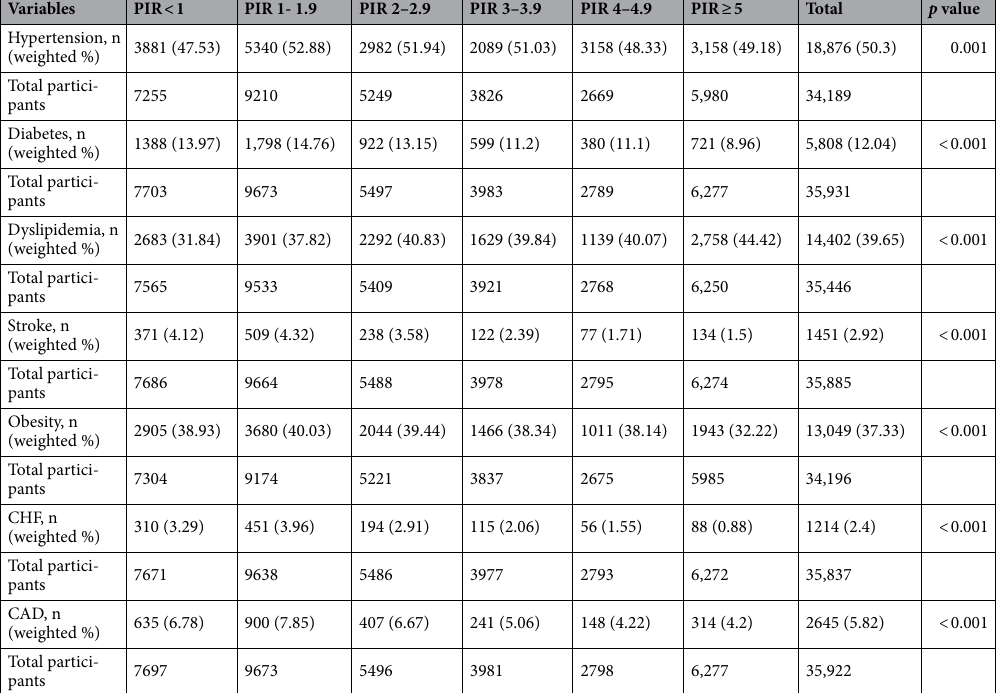
Table 2. Cardiovascular risk factor and cardiovascular disease prevalence stratified by PIR. *Data are presented as unweighted n (weighted percentage). Key: PIR : Family poverty to income ratio, CAD : Coronary artery disease, CHF : Congestive heart